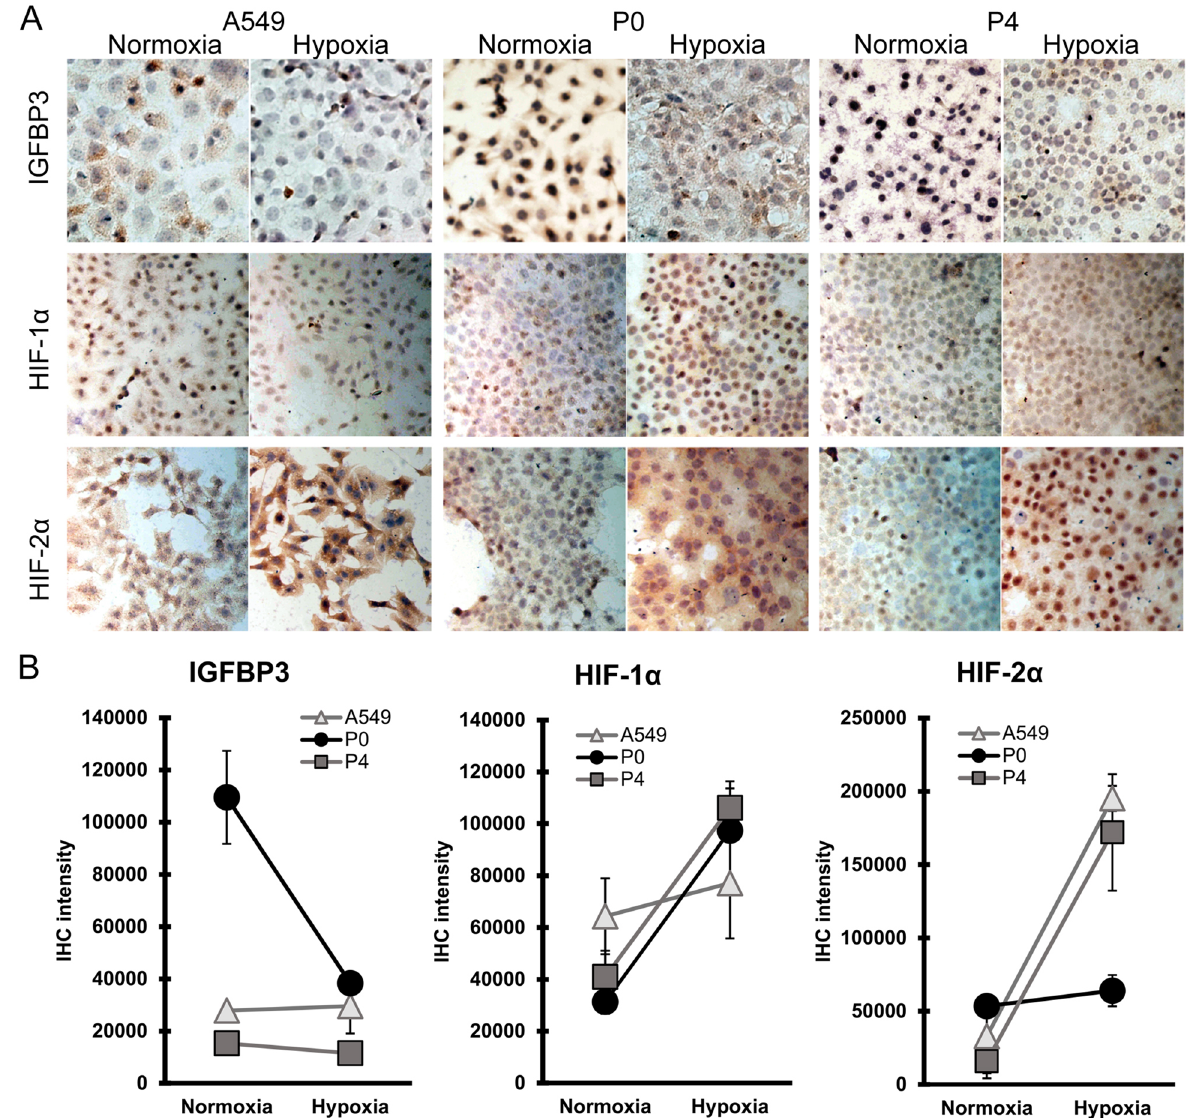
Figure 3. Immunocytochemistry staining of A549, P0, and P4 cell cultures under normoxic and hypoxic conditions for 17 h. ( A ) Under normoxic conditions, P0 expressed more IGFBP3 than P4. P0 showed an increase in HIF-1α, while P4 showed a higher increase in HIF-2α under hypoxia than that under normoxia, indicating that tumor cells without IGFBP3 induced more HIF-2α under acute hypoxic conditions. The A549 cell culture that expressed HIF-2α under hypoxic conditions was used as the study control. ( B ) Quantitative analysis immunohistochemical staining. Images of ICC were taken by Motic Image Plus 3.0 software. The signals of IHC were quantified and analyzed by ImageJ software. Excel 2016 was used to generate charts. Photoshop CS2 version 9 was used to assemble the